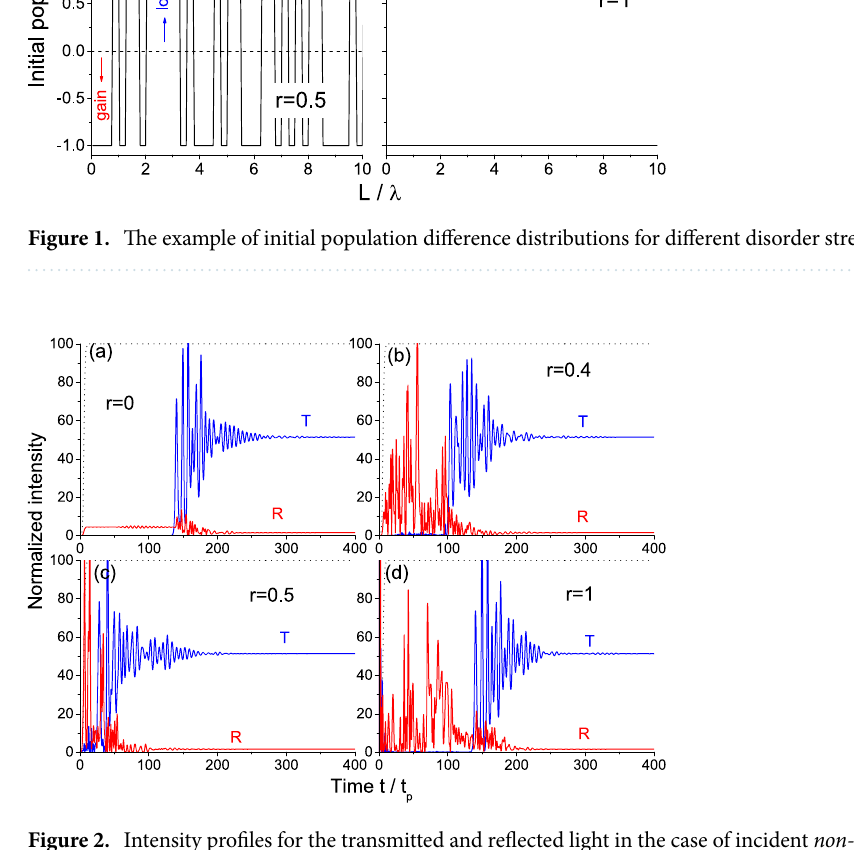
Figure 2. Intensity profiles for the transmitted and reflected light in the case of incident non-adiabatic front. Different panels show the results for different disorder strengths r